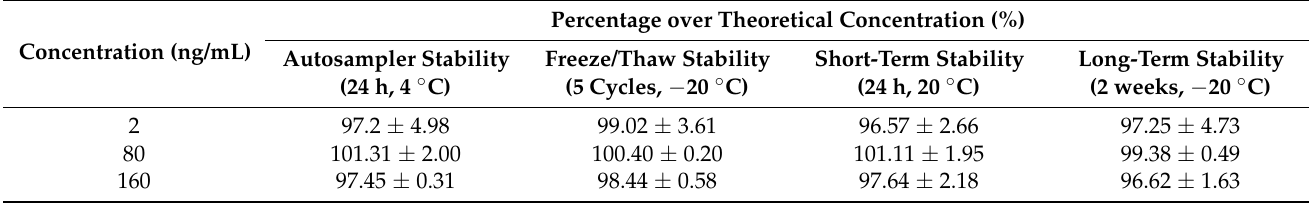
Table 5. Stability of nafamostat in the rat plasma (mean ± SD, n = 3).